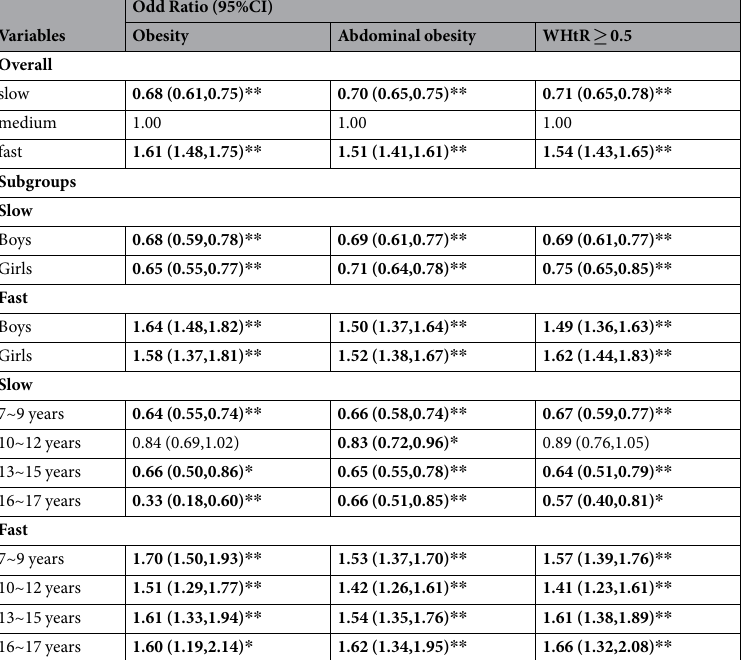
Using multivariate logistic regression model, we analyzed the adjusted association between eating speed and obesity (Table 3). Eating fast (versus medium) showed positive association with obesity (adjusted odds ratio [OR]: 1.61, 95% confidential interval [CI]: 1.48–1.75), abdominal obesity (adjusted OR: 1.51, 95%CI: 1.41–1.61), and WHtR ≥ 0.5 (adjusted OR: 1.54, 95%CI: 1.43–1.65), whereas eating slow (versus medium) showed negative association with obesity (adjusted OR: 0.68, 95%CI: 0.61–0.75), abdominal obesity (adjusted OR: 0.70, 95%CI: 0.65–0.75) and WHtR ≥ 0.5 (adjusted OR: 0.71, 95%CI: 0.65–0.78). Similar associations of eating speed with general and abdominal obesity were observed in both sexes. The odds of eating fast for WHtR ≥ 0.5 was slightly higher in girls (OR: 1.62, 95%CI: 1.44–1.83) than that in boys (OR: 1.49, 95%CI: 1.39–1.63). In the age subgroup analyses, the significant associations of eating speed with obesity indices were also found in each age group, except that eating slow was not significantly associated with general obesity or WHtR ≥ 0.5 in the age group of 10–12 years. Similar results were found when we further adjustment for food intake (Supplementary Table S1).